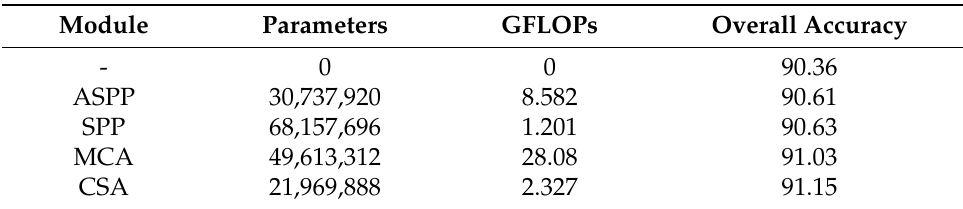
Table 2. Comparison of several semantic extraction modules’ efficiency on ISPRS Vaihingen dataset.